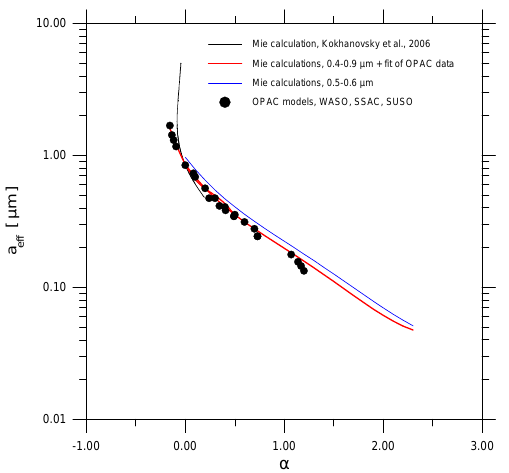
Fig. 5. Correlation between ˚Angstr¨om- α coefficient and effective Fig. A5. Correlation between ˚ Angstr¨om- α coefficient and effective radius as derived from Mie calculations and interpolated data from radius as derived from Mie calculations and interpolated data from O PAC of water soluble O PAC of water soluble particles.